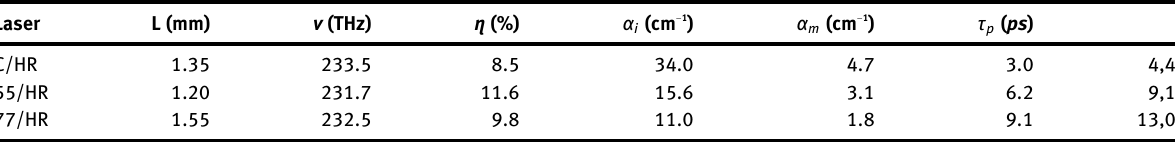
Table  : Extracted parameters for the epitaxial QD lasers on silicon with different front facet re fl ectivity of C/HR,  /HR and  /HR,